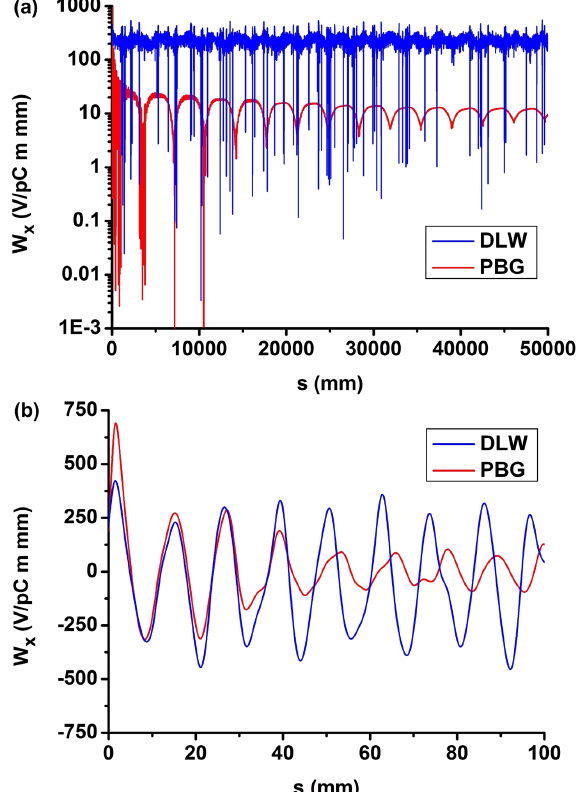
FIG. 6. Comparison of transverse wake potential between DLW and PBG structures. The blue line is DLW wake potential, and the red is PBG wake potential: (a) the envelope of transverse wake potential in DLW and PBG along 50 000 mm; (b) the first 100 mm transverse wake potential in both structures.